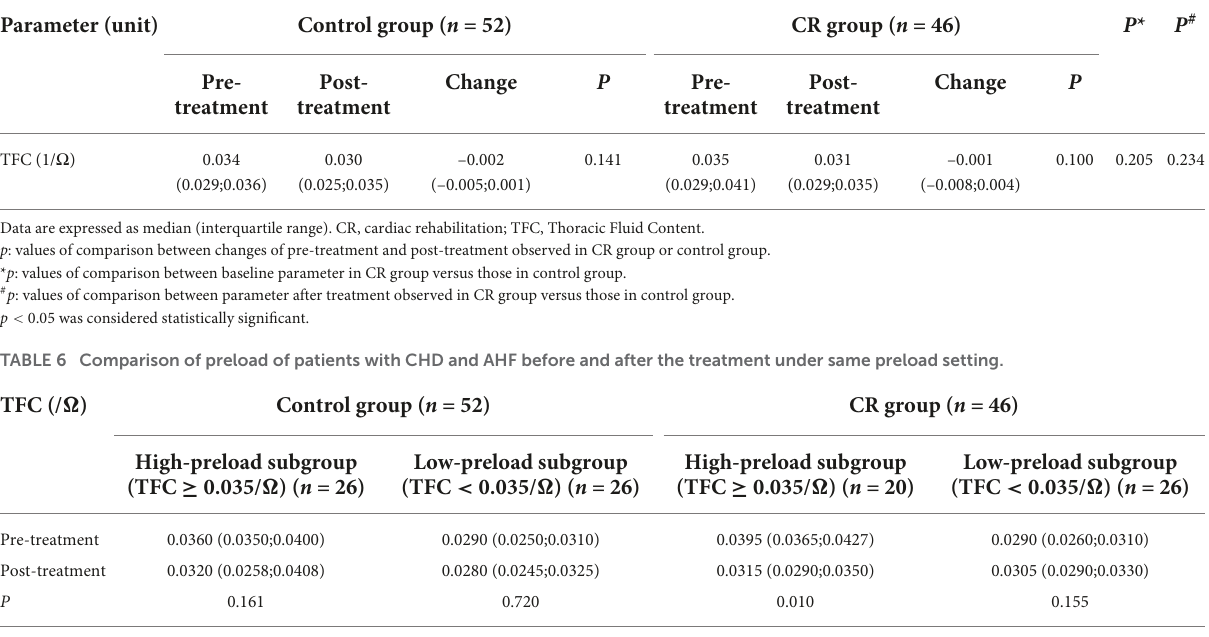
TABLE 5 Comparison of preload parameter measured by impedance cardiography of patients with CHD and AHF before and after the treatment.